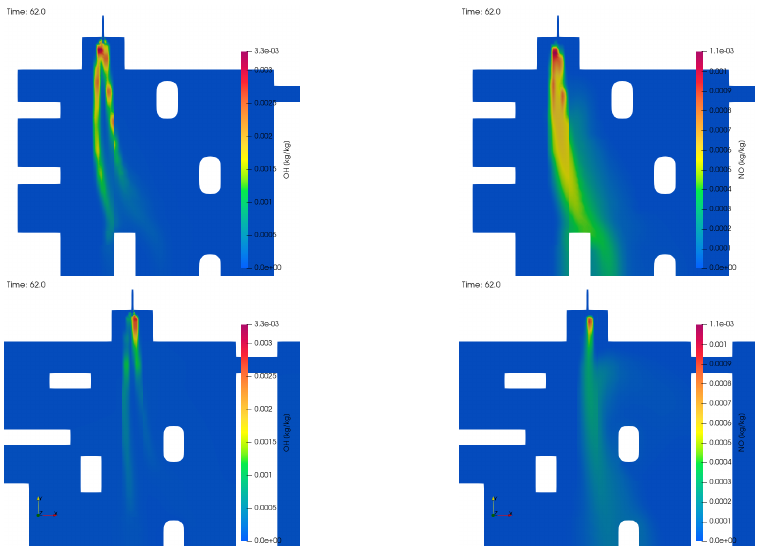
Figure 11. Computed mass fraction of OH ( left ) and thermal NO ( right ) near Burner-1 ( top ) and near Burner-2 ( bottom ) at t = 62 s of computation